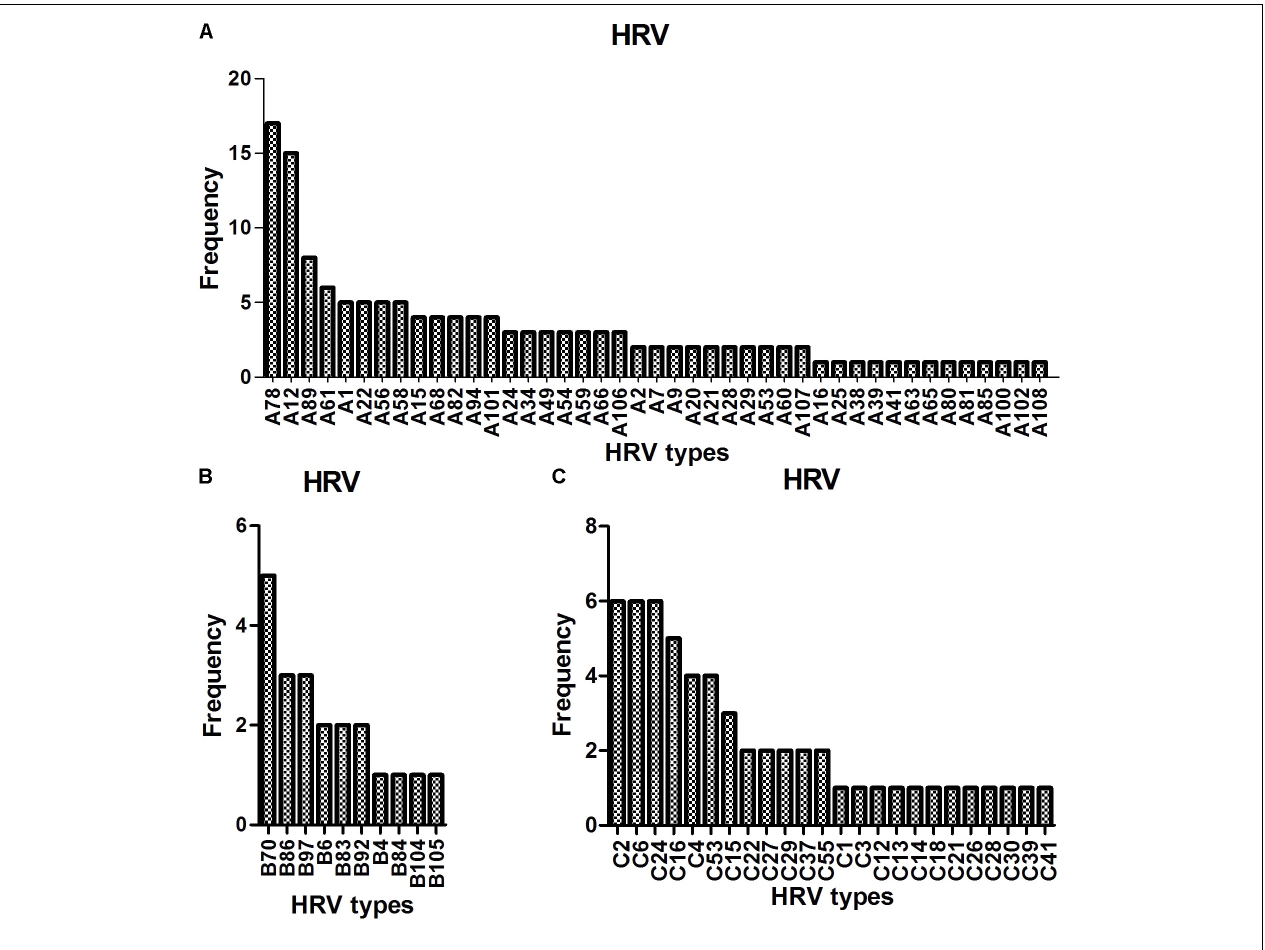
FIGURE 2 | Detection of HRV genotypes in the study (A–C) . TABLE 2 | Clinical characteristics of patients with HRV infections in the